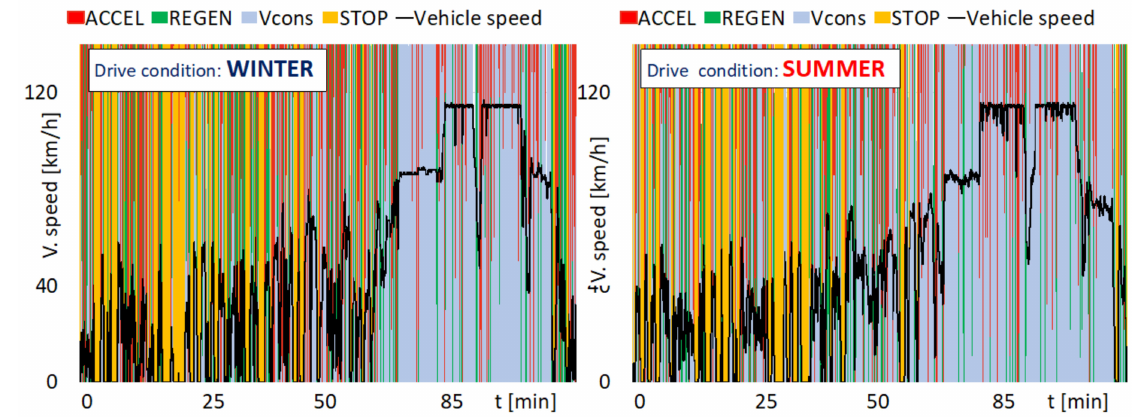
Figure 11. Distribution of motion phases in winter and summer conditions.